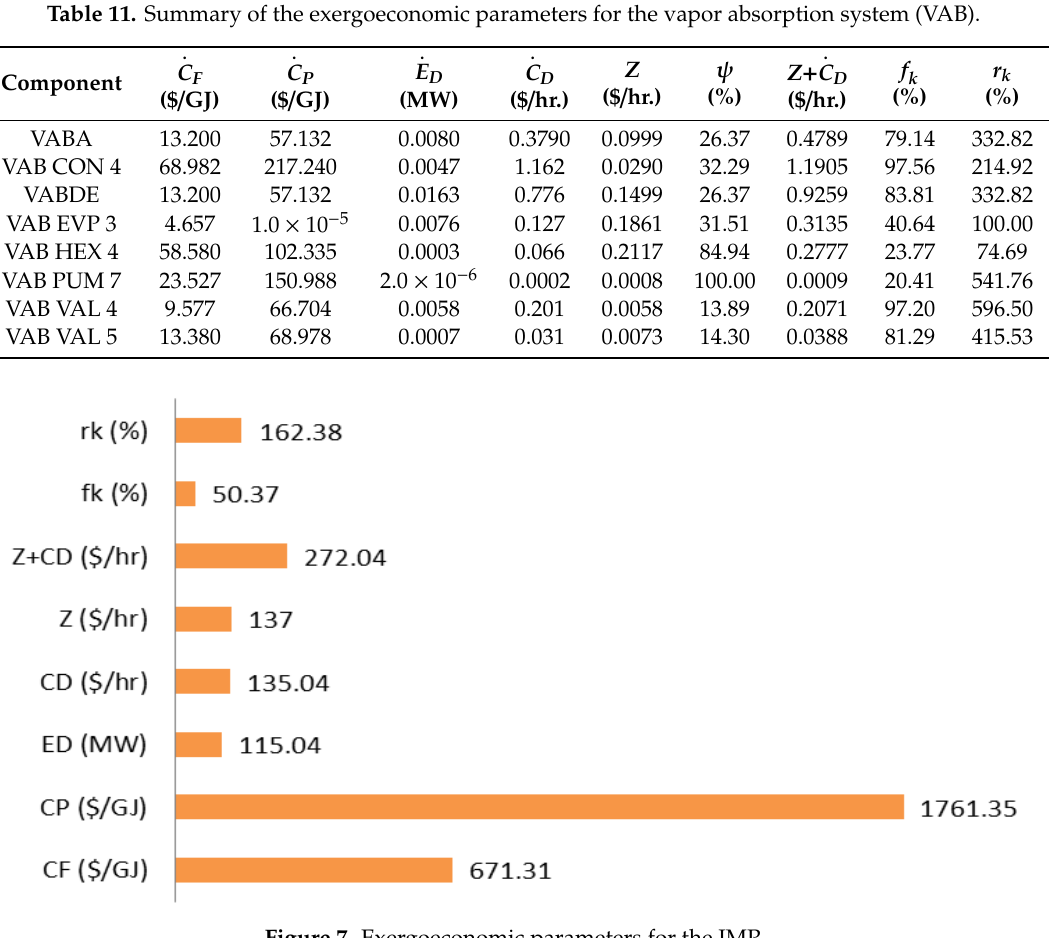
Table 11. Summary of the exergoeconomic parameters for the vapor absorption system (VAB).